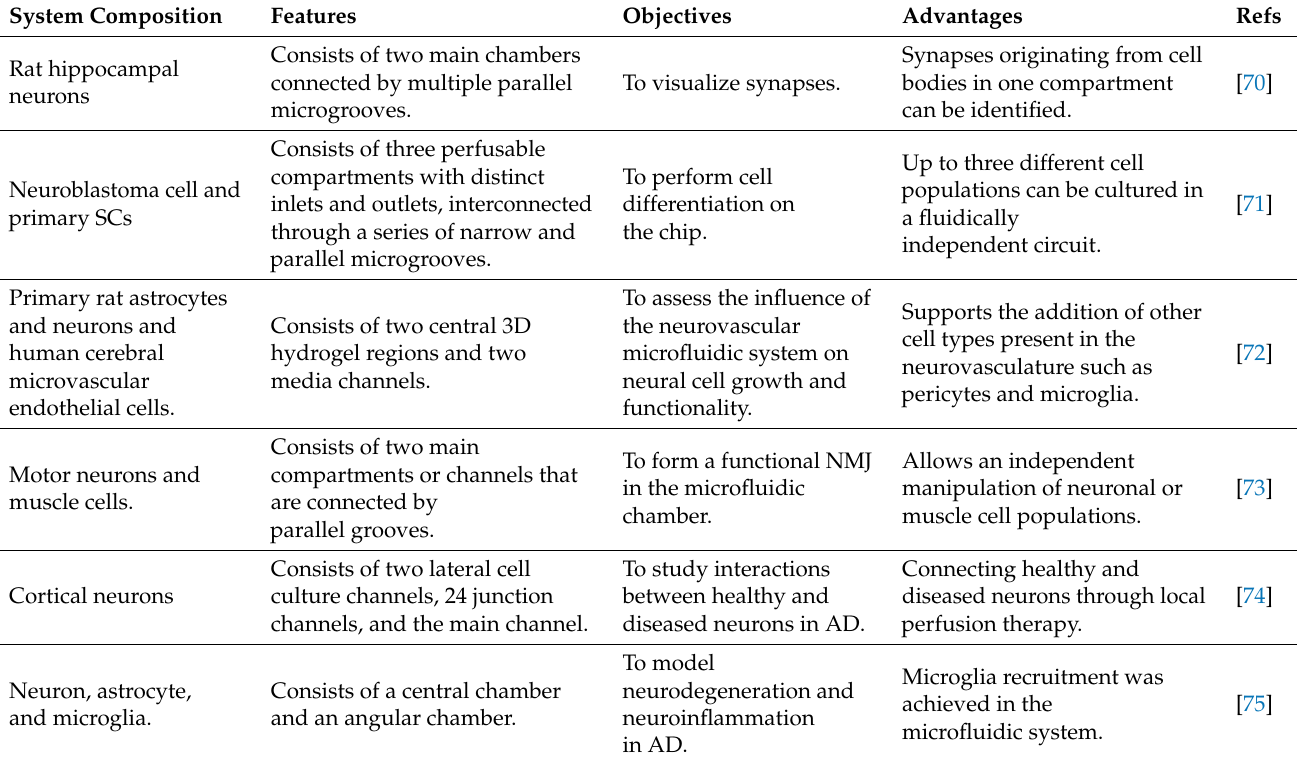
Table 4. Microfluidic